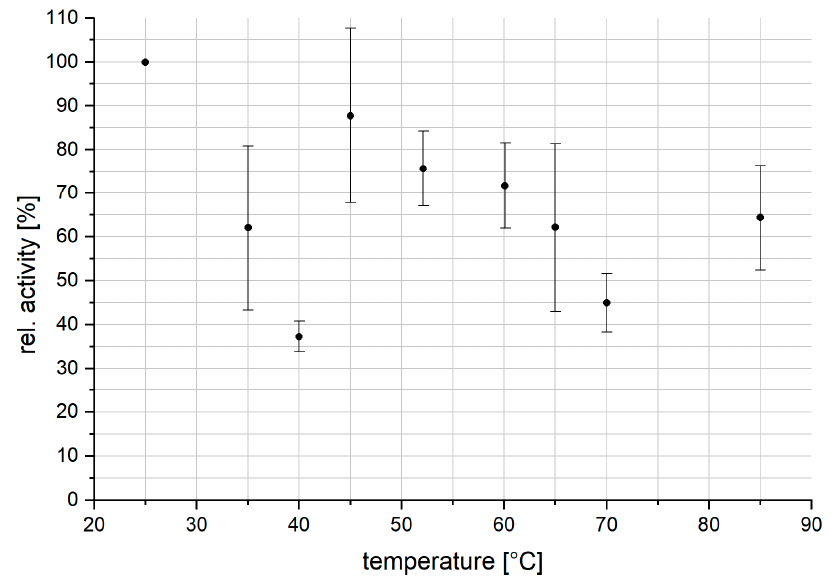
Figure 7. Relative activity of VPO-RR after incubation at different temperatures for three hours. The activity of each sample was normalized to the activity of the sample incubated at 25 °C. The uncertainties indicate the standard deviation of triplicate measurements.